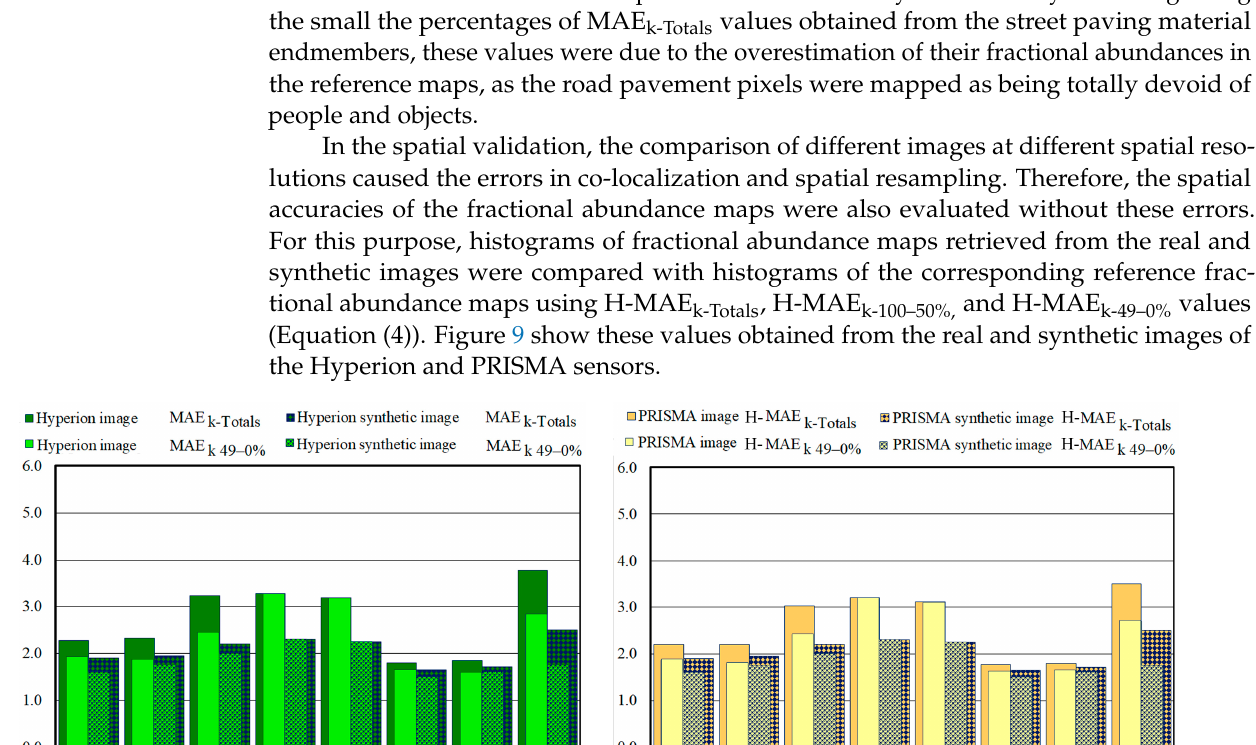
Table 7. The percentage of H-MAE k-Totals values due to the sensor characteristics added to the biases in the simulation of real data.